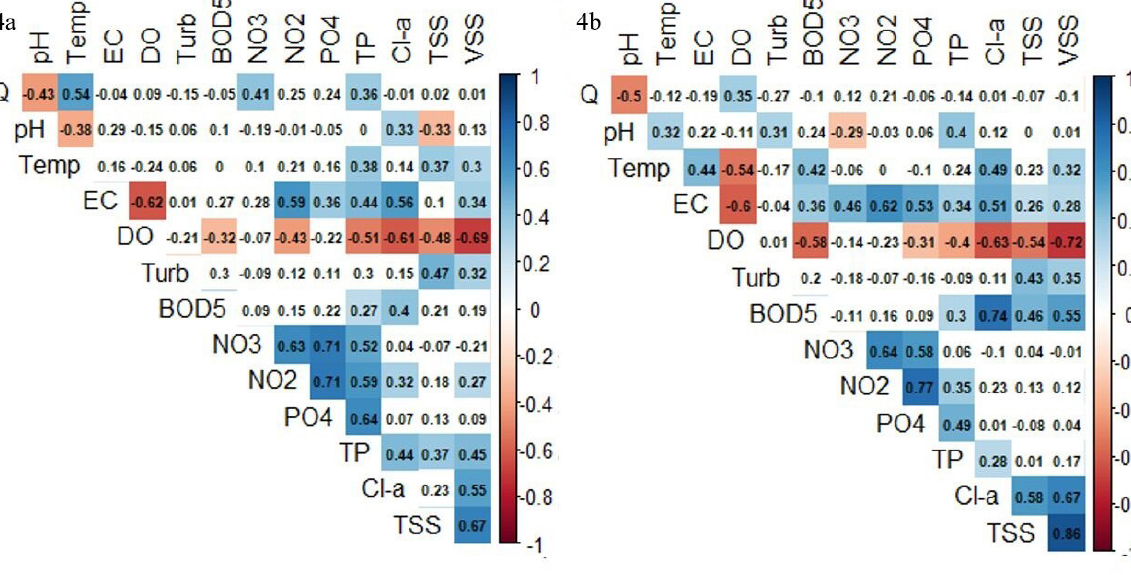
Figure 4. Correlation matrix by the Spearman method for the dry season (a) and the rainy season